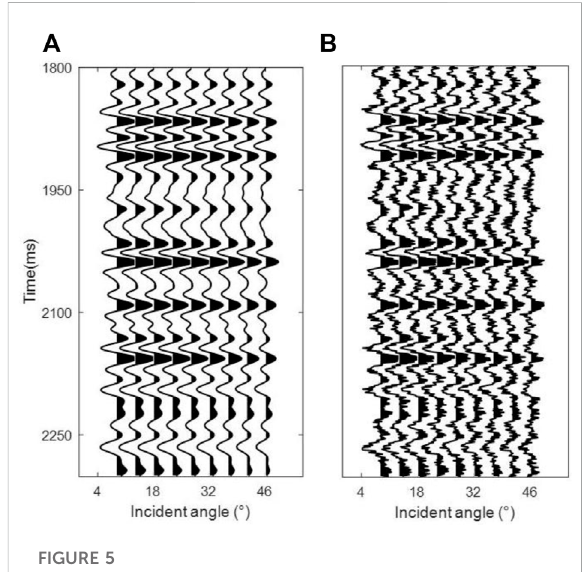
FIGURE 5 Synthetic pre-stack angle gathers: (A) original noiseless data; (B) added random noise SNR = 2. Each angle is 6 ° , 11 ° , 16 ° , ... , 46 °